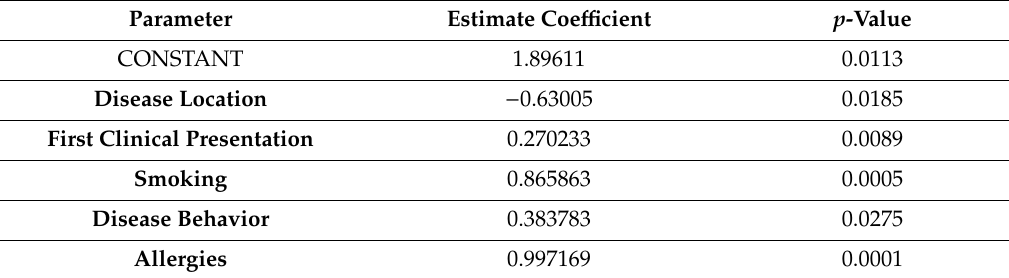
Table 3. Multiple regression analysis of factors associated with circulating TBARS in Crohn’s patients.